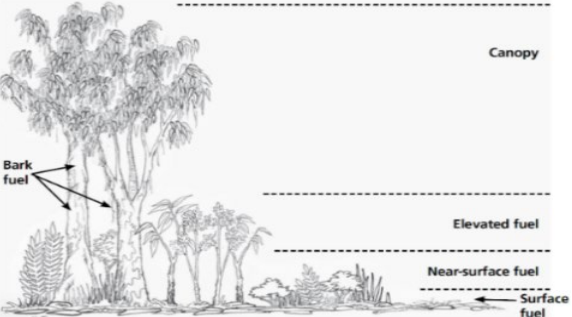
Figure 2: Five structural layer in a forest profile ((Hines, Tolhurst et al.